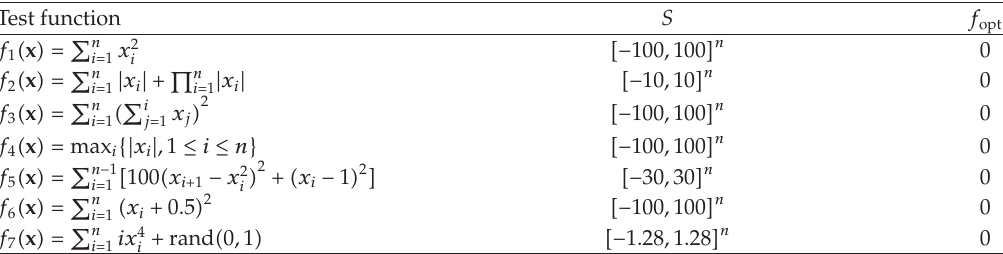
Table 12: Unimodal test functions.